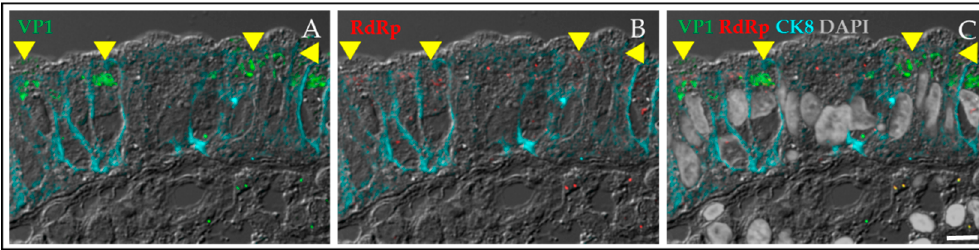
Figure 1. Human norovirus (HuNoV) replicates in enterocytes. Viral antigen was detected in a duodenal biopsy from an individual with common variable immune deficiency who was chronically infected with human norovirus. The biopsy was positive for HuNoV RNA. The viral capsid antigen VP1 in green ( A ) and the viral nonstructural protein, RNA-dependent RNA polymerase (RdRp) in red ( B ) were detected in enterocytes outlined by cyan staining for the epithelial marker cytokeratin 8 (CK8). The yellow arrows highlight cells expressing both the viral capsid antigen and the polymerase. There is little intestinal inflammation in this biopsy from a patient not on immunosuppressive therapy and few cells in the lamina propria show VP1 staining ( C ). Scale bar, 10 µm.